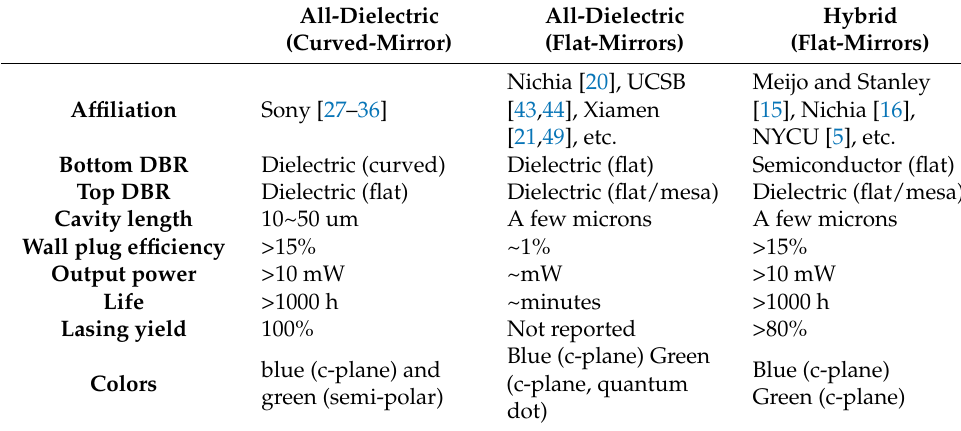
Table 2. Comparison between major structures reported for GaN-based